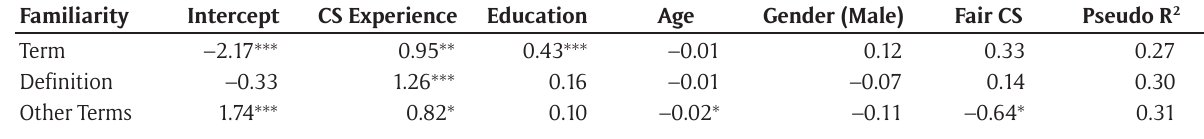
Table 1: Regression coefficients for three measures of familiarity with the concept of citizen science: Familiarity with the term, recollection of hearing about citizen science after being provided with a definition, and familiarity with other similar terms. For details on independent variables, see text. Asterisks indicate significant p-values for coefficients: *p < 0.05, **p < 0.01, ***p < 0.001. N =